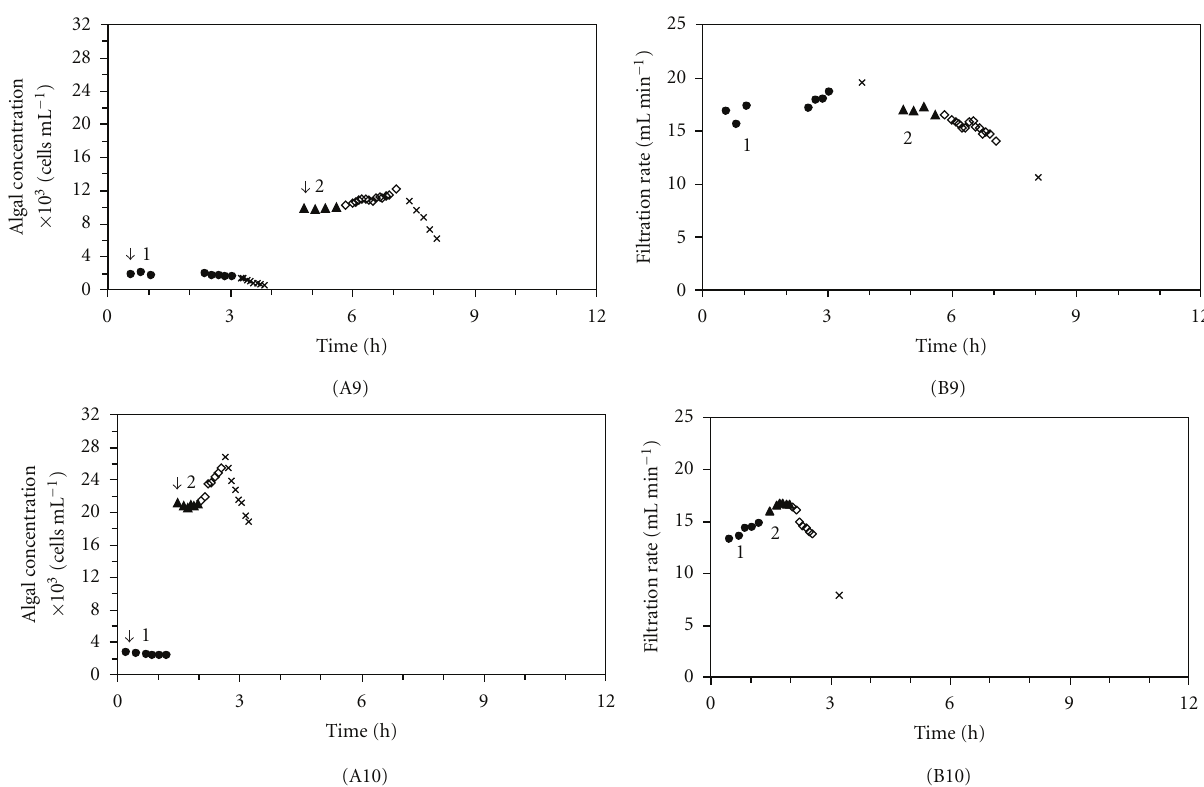
Figure 3: Mytilus edulis . Steady-state feeding experiments (no. 1 to no. 10, Table 1) conducted with a group of 20 mussels during a period of 50 days. (A) Measured algal concentration in aquarium with mussels. Arrows indicate addition of algal cells to instantly establish a desired new algal concentration. (B) Estimated filtration rate using (1) (open and closed symbols) or using (2) (cross). Symbols: closed circle is steady state at low algal concentration (about 2,000 cells mL − 1 ); closed triangle is steady state at high algal concentration ( > 2,000cells mL − 1 ); open square is algal concentration after incipient saturation of mussels; cross is reduction in algal concentration after stoppage of algal dosing pump and water through-flow. Numbers indicate series (Table 1).